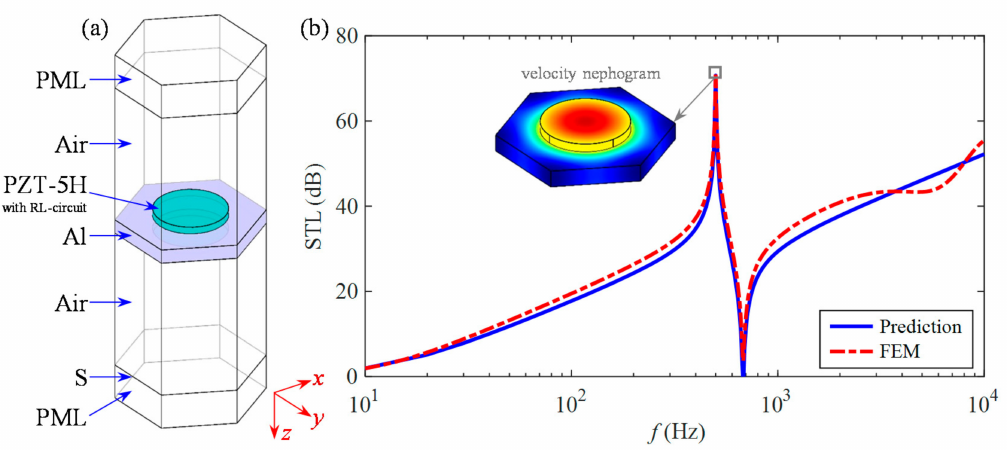
Figure 3. Finite-element simulation verification of the present metamaterial: ( a ) multiphysics geome- try model and ( b ) sound insulation.